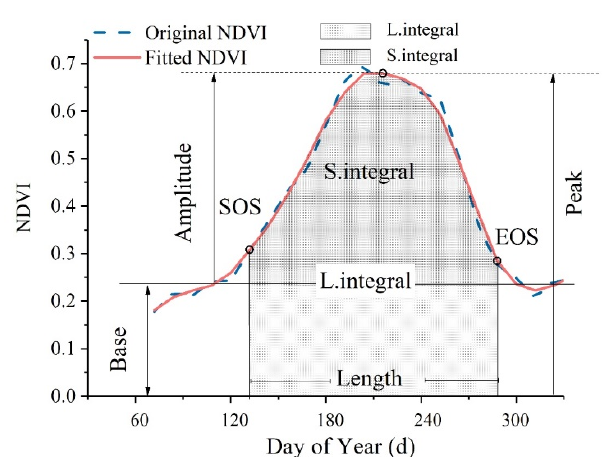
Figure 4. Phenological indicators extracted from TIMESAT: amplitude, start of season (SOS), end of season (EOS), base value, large integral (L. integral), small integral (S. integral), peak, and growth phase length (length).